Question: Provide a one-line summary of what is displayed.
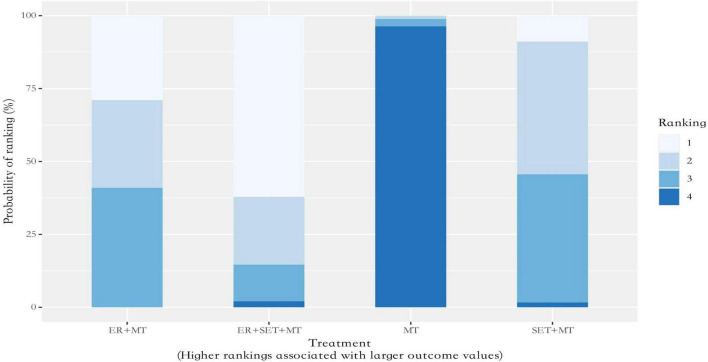
Answer: Ranking probability distribution for all-cause mortality. Lighter colors represent higher treatment rankings and lower mortality risk.